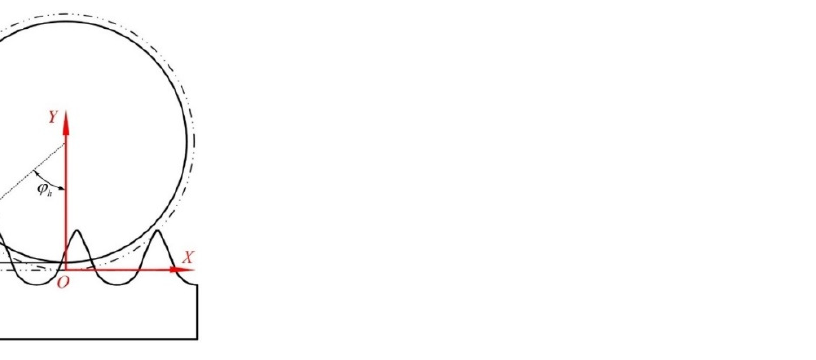
Figure 7. Schematic diagram of the moment when the roller pin is out of engagement. The parameters of the trochoidal roller pinion rack are shown in Table 2. Figure 8 is the curve of the line of action drawn according to Equations (4) and (6). Table 2. Parameters of trochoid roller pinion rack. Name